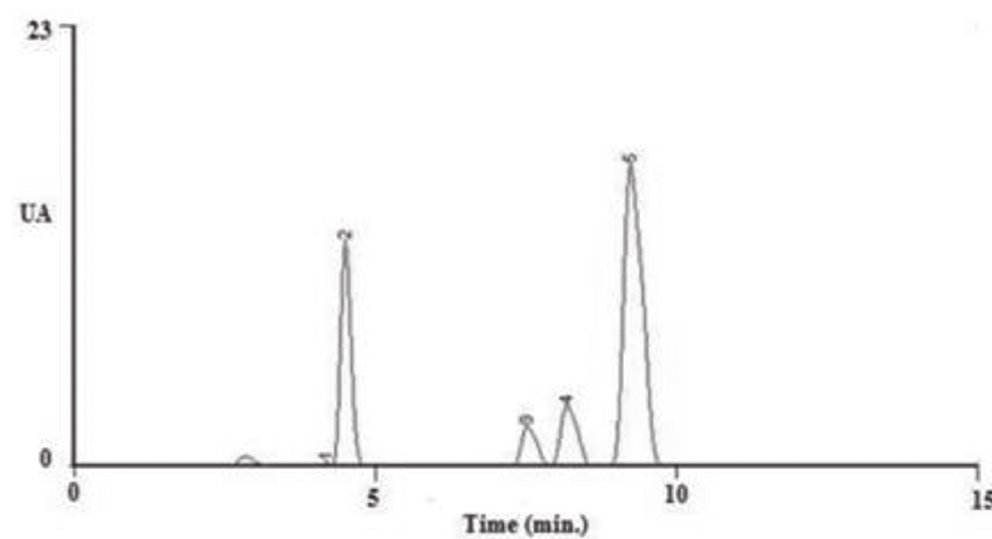
FIGURE 5 - Chromatogram of the solution obtained after the contamination of pig ear skin. The contaminant solution contained a mixture of active substances: octyl-p-methoxycinnamate (OMC), benzophenone-3 (BP-3), ethylhexylmethoxycrylene (EHMCR), each substance at 20 μg.mL -1 . The retention time (min.) and area unit (AU) of each active substance correspond, respectively, to: BP-3, peak 2, 4.50 min. and 236782.08 AU; trans isomer of EHMCR, peak 3, 7.53 min. and 63504.15 AU; cis isomer of EHMCR, peak 4, 8.18 min. and 104300.85 AU; OMC, peak 5, 9.24 min. and 565367.50 AU. The chromatographic conditions were Gilson equipment (Shimadzu, Canby, OR, USA); Gilson Unipoint 3.0 software system controller (Gilson, Bedfordshire, UK); reverse- phase column (C18); 320 nm; 40 o C; acetonitrile:water (90:10) and 1.0 mL.min -1